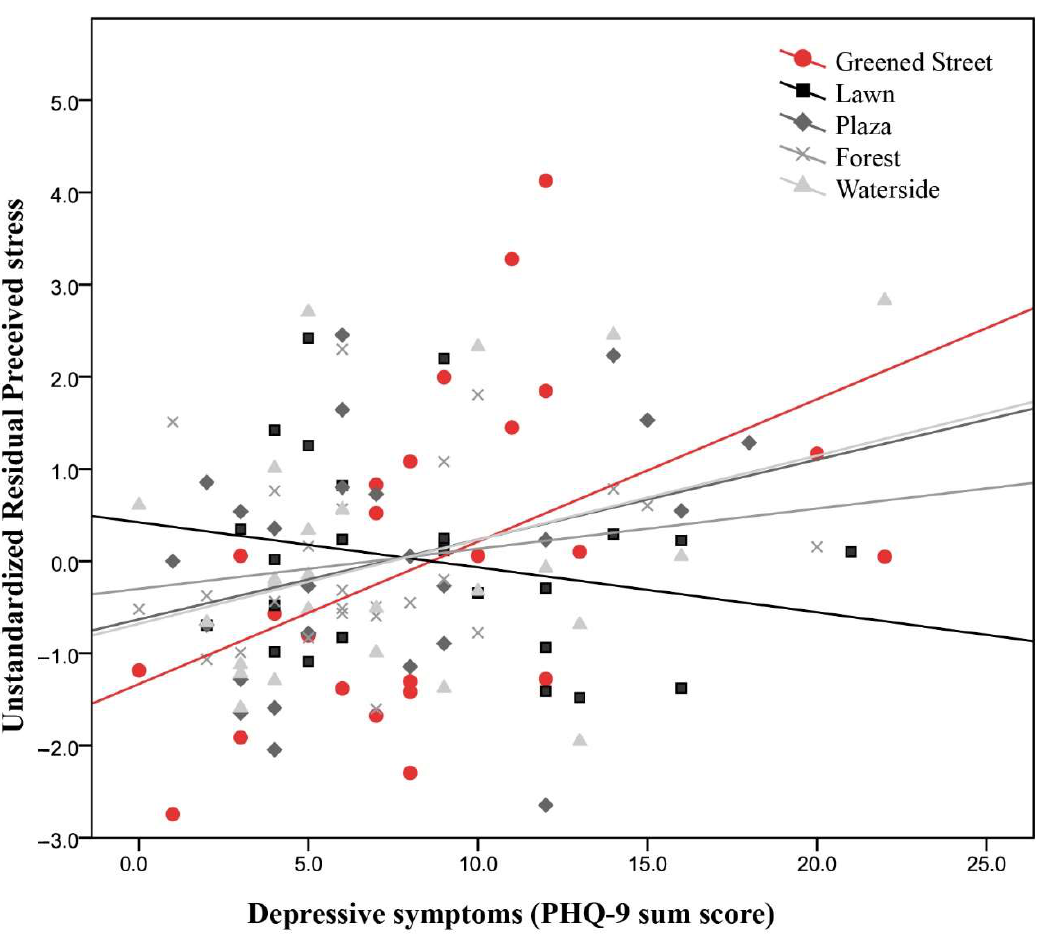
Figure 6. Plotted regression model for perceived stress (T3) corrected for the pre-video (T1) stress level and gender